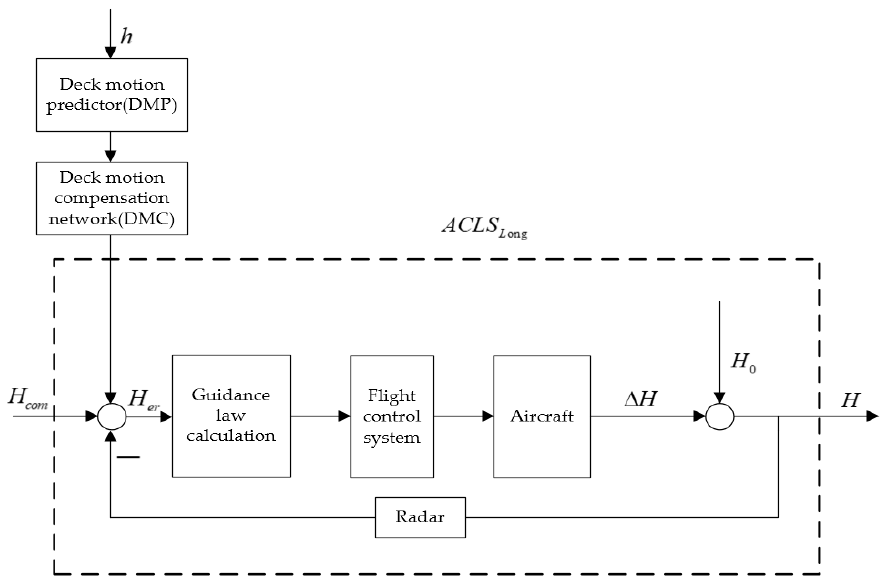
Figure 1. The structure of the longitudinal automatic landing guidance system with deck motion predictor and compensator.